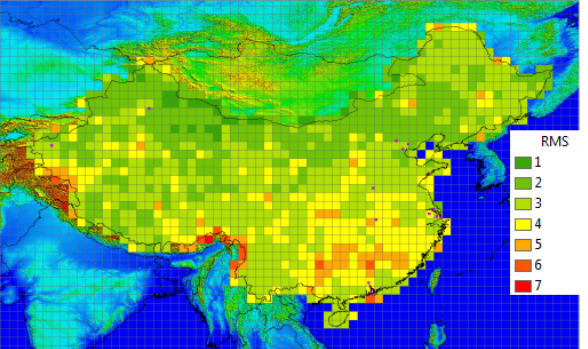
Figure 9. China, RMS elevation difference (m) between SRP points and WD4O V2 DTM/DSM